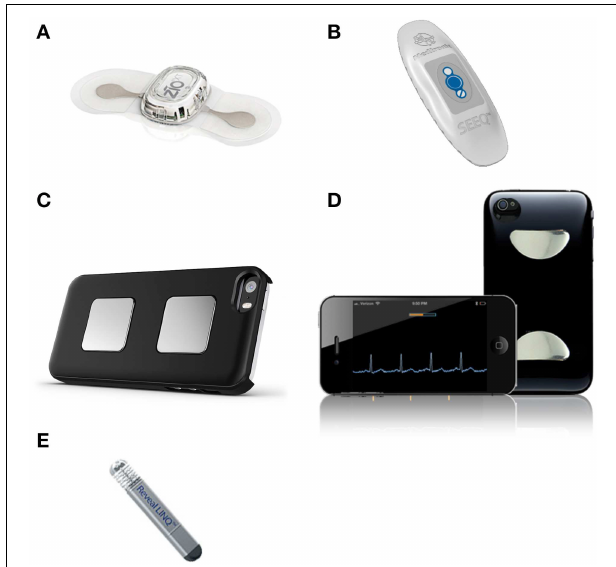
FIGURE 2 | A selection of contemporary wireless mobile cardiac monitoring devices. Two leading AECG adhesive patch devices on the medical device market today are (A) second-generation ZIO ® XT Patch by iRhythm Technologies, Inc. and (B) SEEQ ™ MCT patch device by Medtronic, Inc. (cellular transmitter not shown). Featuring touch-activable electrodes configured for the Apple iPhone or Androidbased systems are (C) third-generation AliveCor ® by AliveCor, Inc. and (D) ECG Check by Cardiac Designs, LLC. As the first-in-class injectable cardiac monitor, (E) Reveal LINQ ™ (4. 0 × 7 . 2 × 44 .8mm; 2.4 g) by Medtronic, Inc. can record rhythm data for up to 3 years.